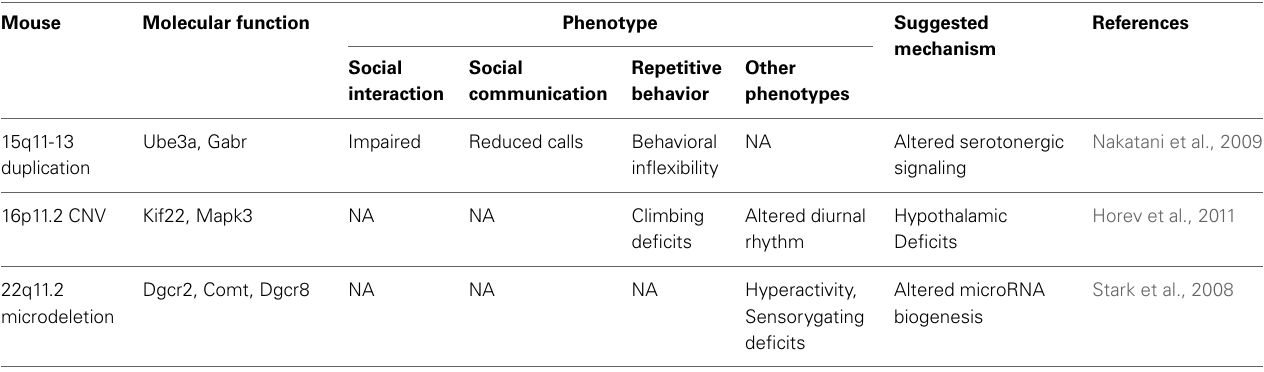
Table 3 | ASD models with chromosomal abnormality.